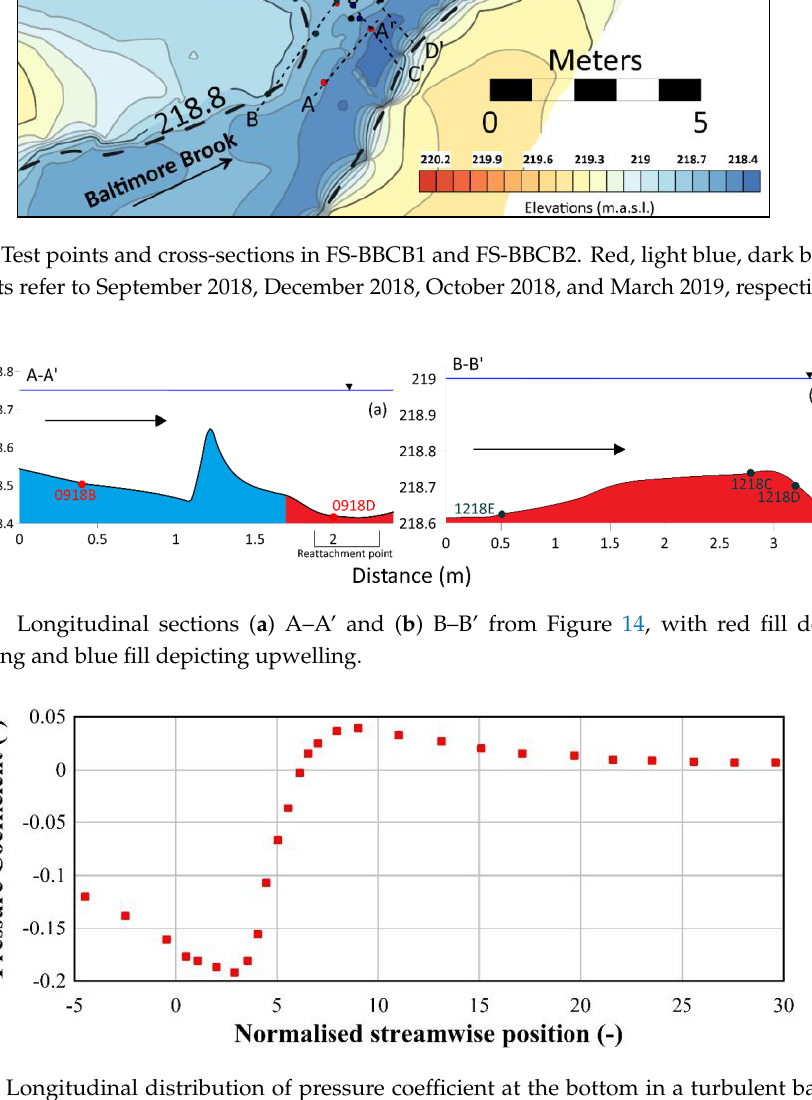
Figure 16. Longitudinal distribution of pressure coefficient at the bottom in a turbulent